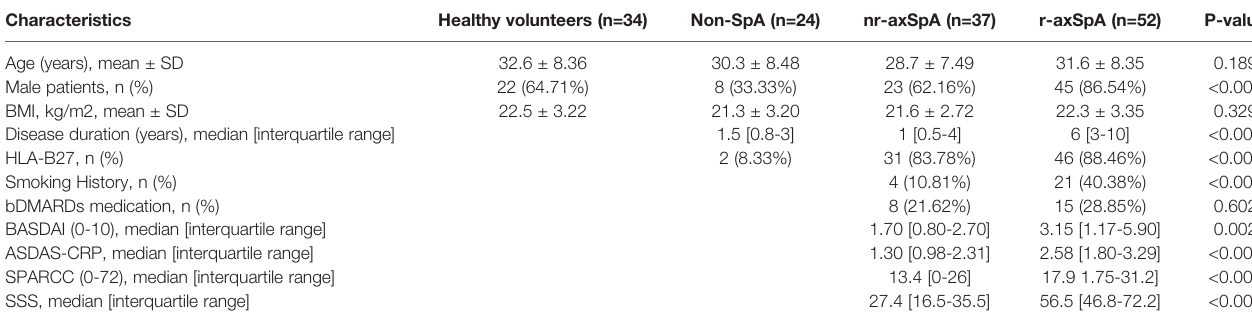
TABLE 1 | Characteristics of included participants. Characteristics